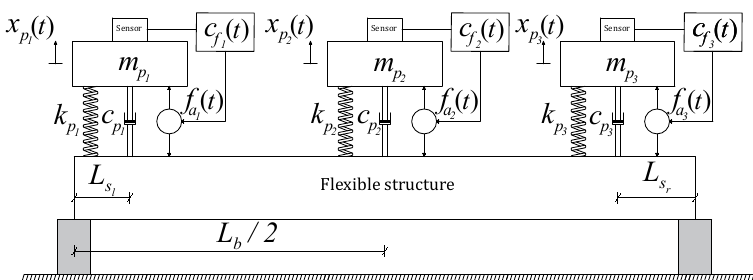
Figure 4. Illustration of three isolators situated on a flexible beam